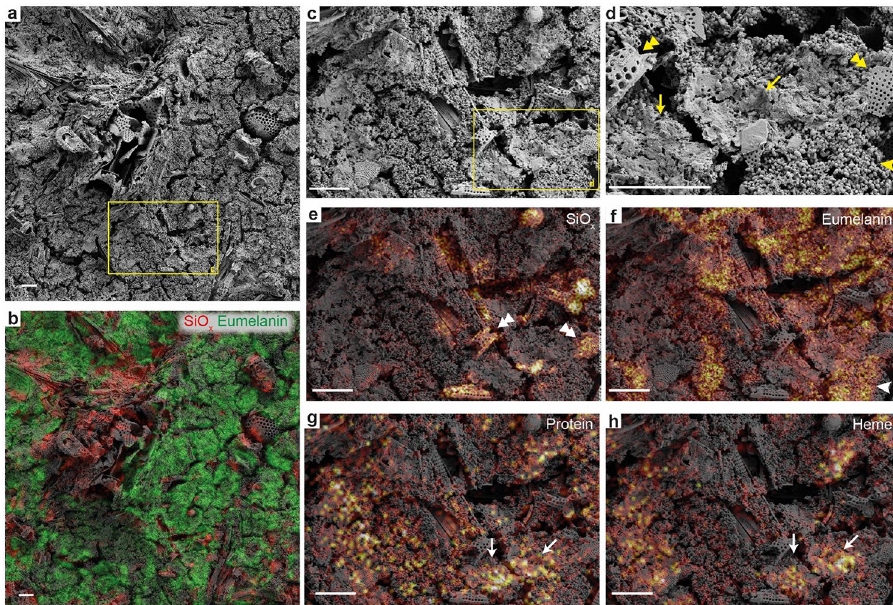
Figure 7. ToF-SIMS and SEM images of organic residues in demineralized samples obtained from the flipper residue in DK 807. ( a ) SEM micrograph of melanosomes and sheet-like matter overlying diatom frustules (the latter from the surrounding sediment). ( b ) Overlay of the SEM micrograph in ( a ) together with negative-ion images representing eumelanin in green (C 4 H − , C 3 N − , C 3 NO − , C 6 H − and C 5 N − ) and sediment in red (SiO 2 − , SiO 3 − and SiHO 3 − ). ( c ) Higher magnification SEM micrographs of the area denoted by a yellow box in ( a ). ( d ) Higher magnification SEM micrograph of the area indicated by a yellow box in ( c ). ( e – h ) Overlays of the SEM micrograph in ( c ) with individual ToF-SIMS ion images representing ( e ), silica (SiO 2 − , SiO 3 − and SiHO 3 − ); ( f